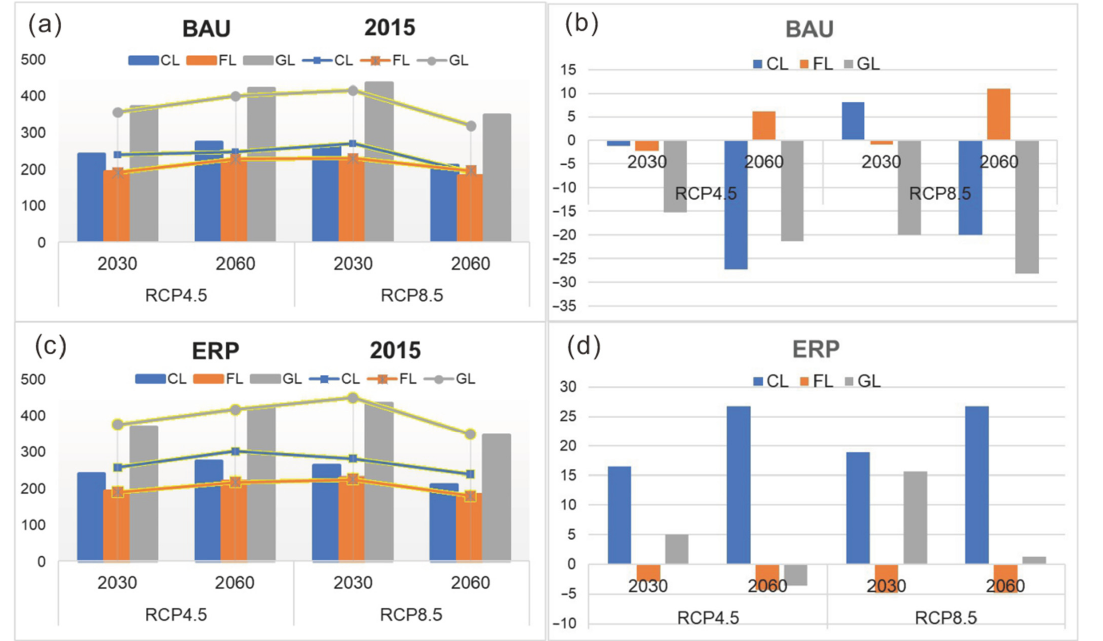
Figure 4. Soil erosion modulus in three LUC patterns. (CL represents cropland, FL represents forestland and GL represents grassland.) (( a ) Soil erosion modulus of BAU model under RCP4.5 and RCP8.5 scenarios; ( b ) soil erosion modulus change of BAU model under RCP4.5 and RCP8.5 scenarios; ( c ) soil erosion modulus of ERP model under RCP4.5 and RCP8.5 scenarios; ( d ) soil erosion modulus change of ERP model under RCP4.5 and RCP8.5 scenarios).